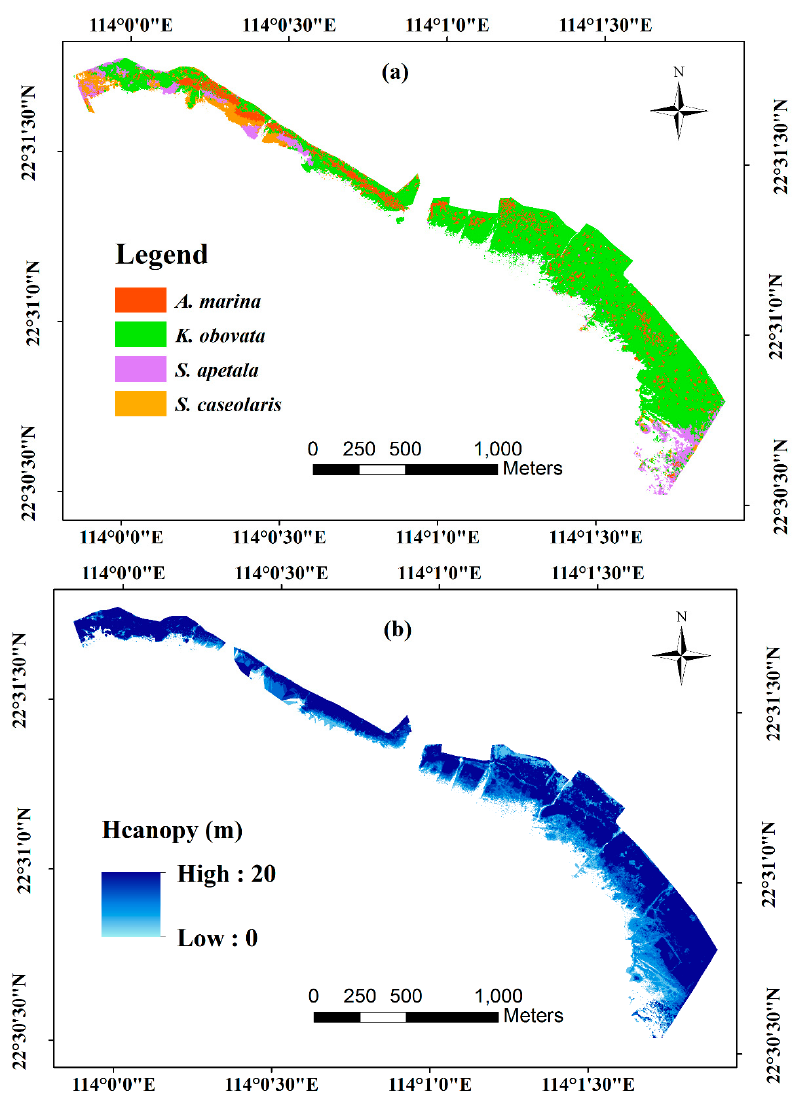
Figure 3. The classification of mangrove species ( a ) and canopy height model (CHM) ( b ) of the study